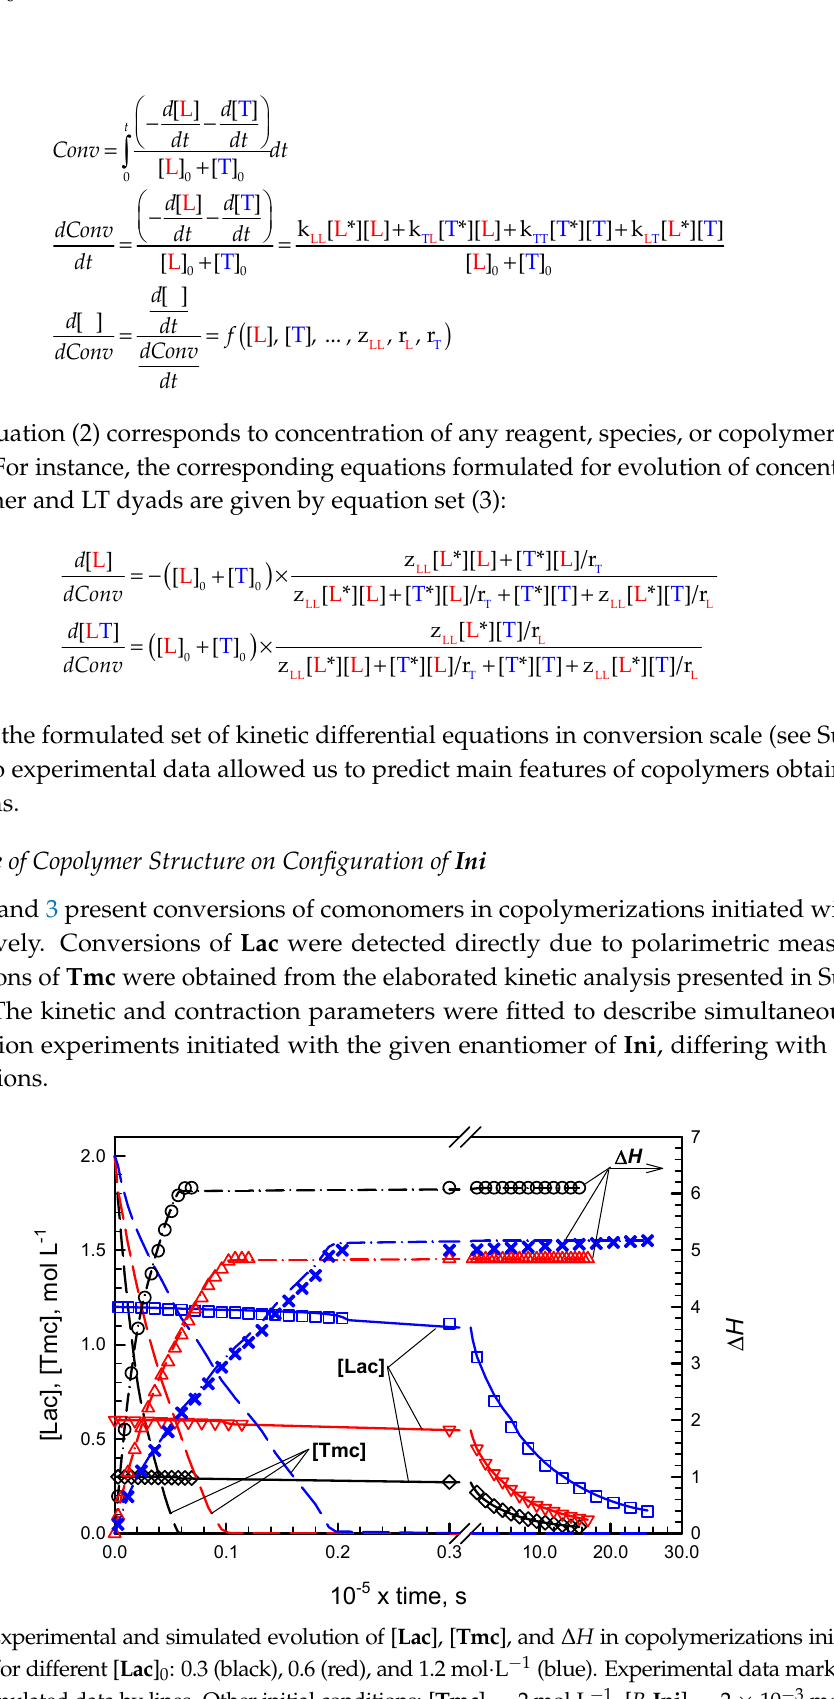
Figure 3. Experimental and simulated evolution of [ Lac ], [ Tmc ], and Δ H in copolymerizations initiated with S - Ini . Plots description and copolymerization conditions as given in caption for Figure 2, but R - Ini enantiomer was used. While in systems with R initiator enantiomer, initially mostly Tmc is consumed, giving presumably the product resembling diblock copolymer, in systems with S - Ini we obtained product containing in the initial parts of chains both comonomers in similar quantities. The chains are terminated eventually with Tmc blocks due to the fact that Lac was consumed before Tmc , used in significant excess. Kinetic analysis confirms this description of products giving both reactivity ratios